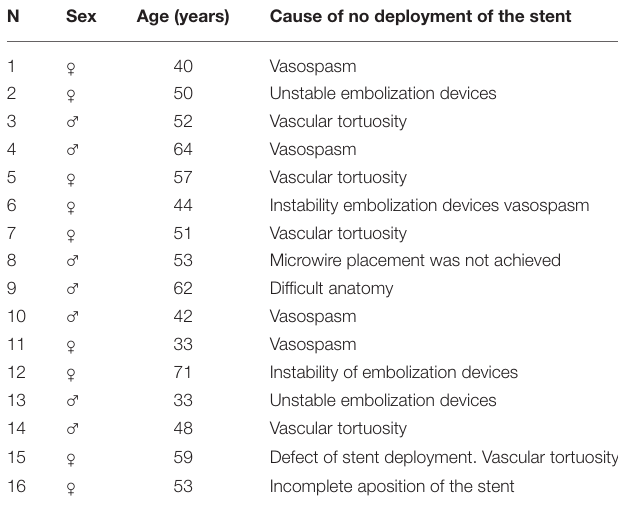
TABLE 1 | Summary of causes of unsuccessful deployment of stents and posterior